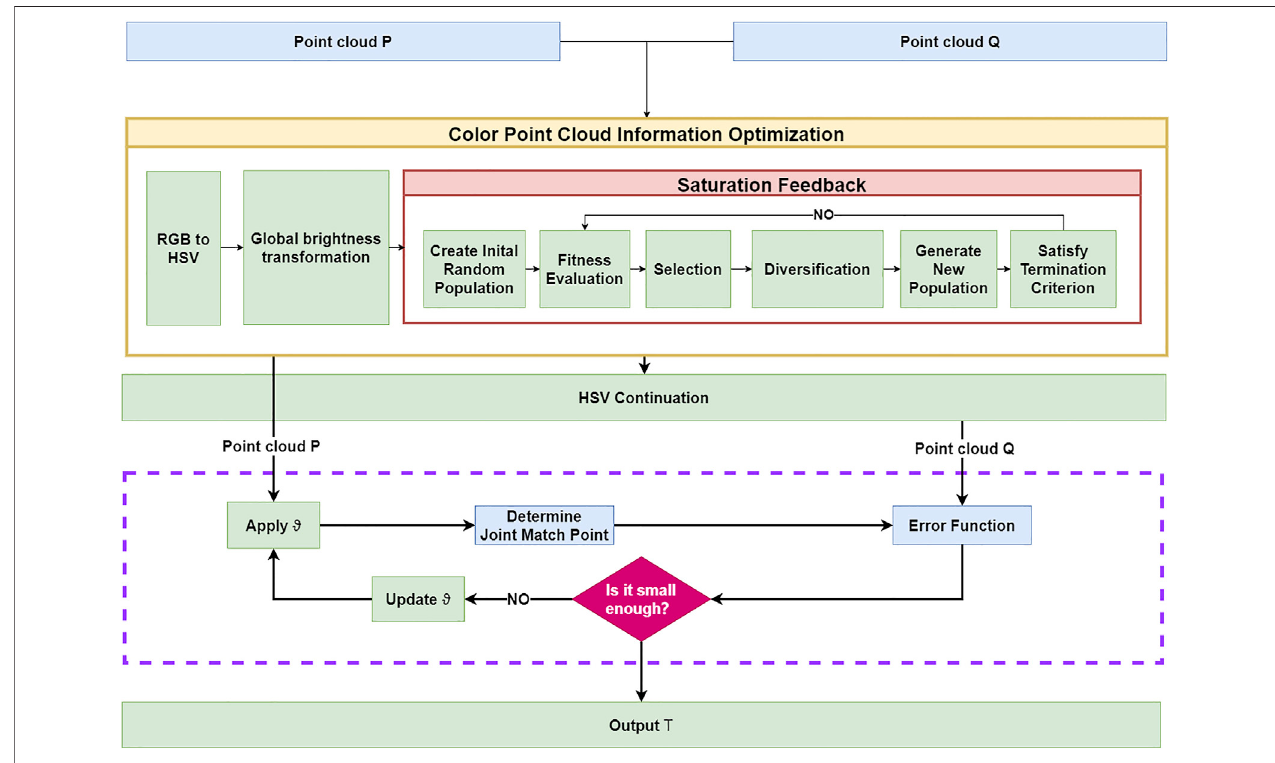
FIGURE 1 | Algorithm